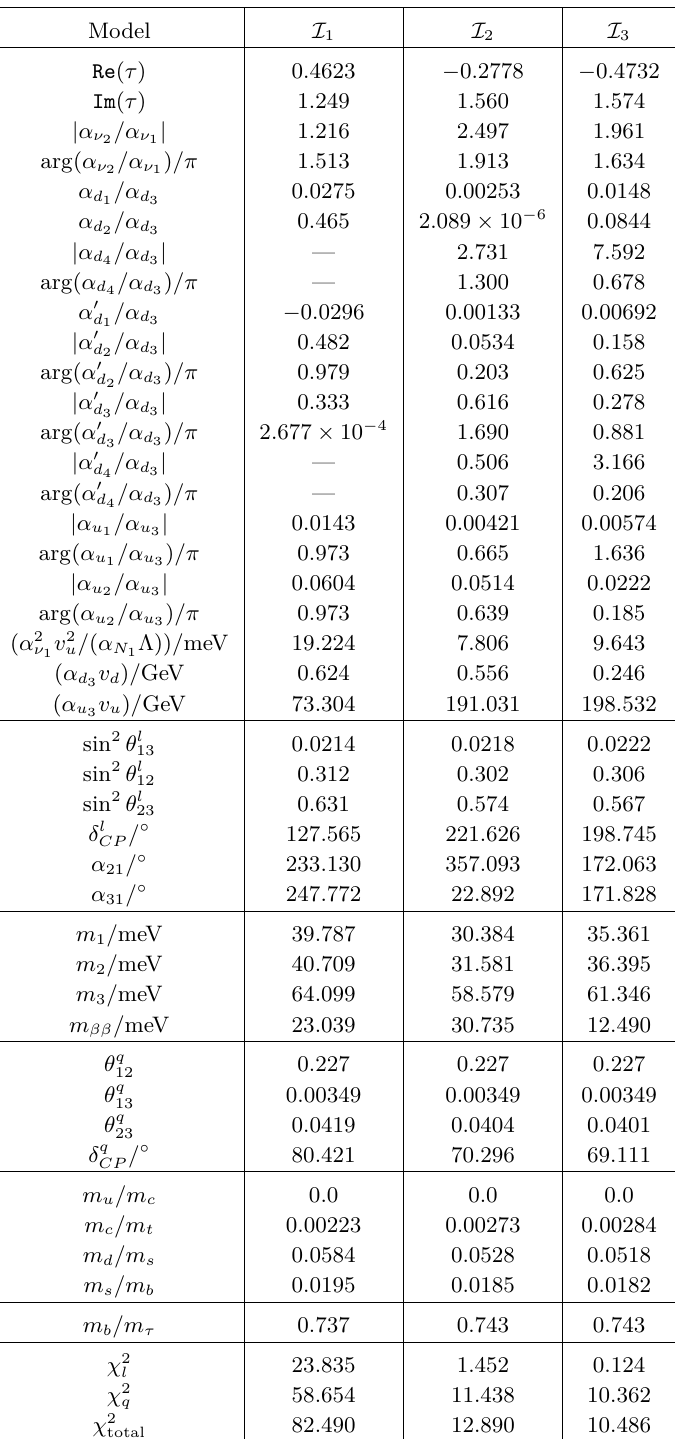
Table 4 . The best fit values of the free parameters and the corresponding predictions for lepton and quark mixing parameters and fermion masses for the phenomenologically viable models of